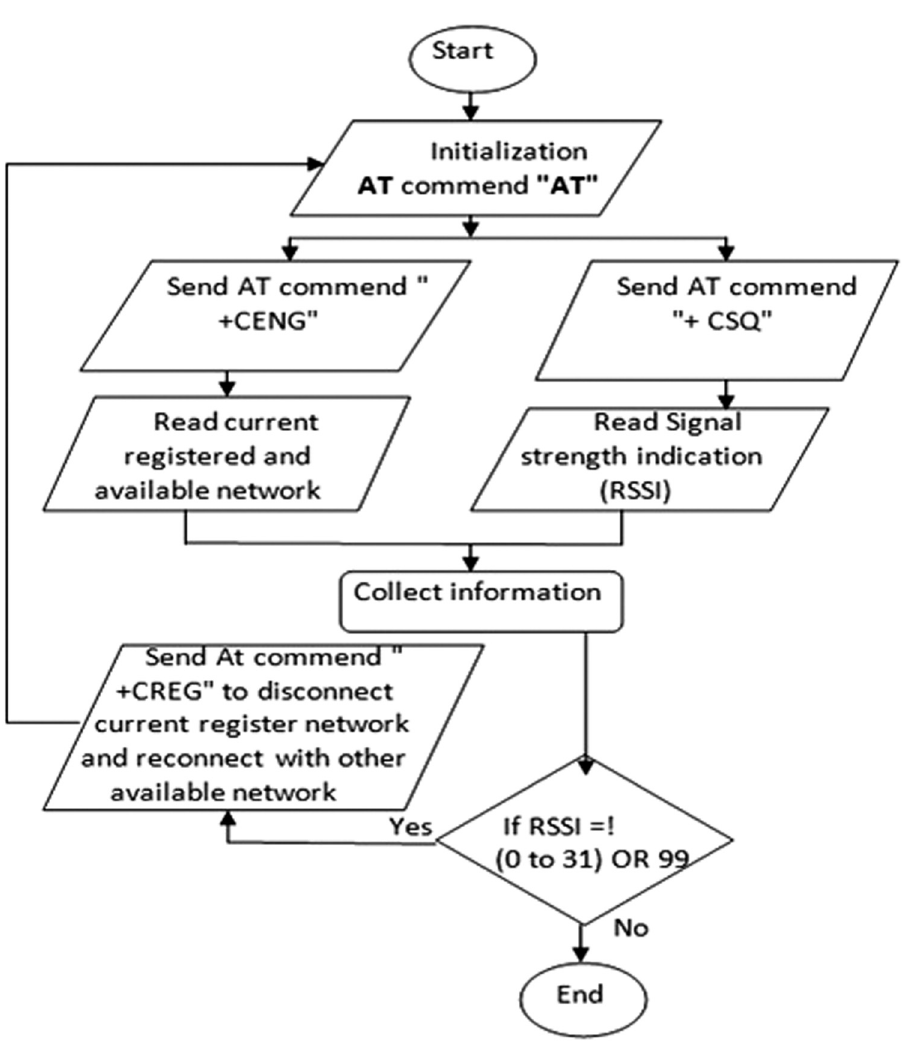
Figure 4: Reduction coverage holes